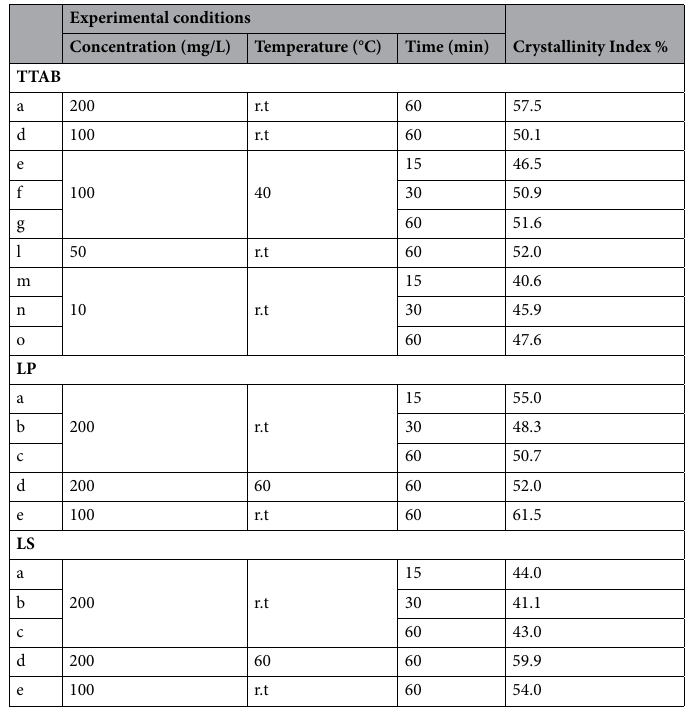
Table 2. Crystallinity Index of the Spanish broom fiber treated with different softeners and under different experimental